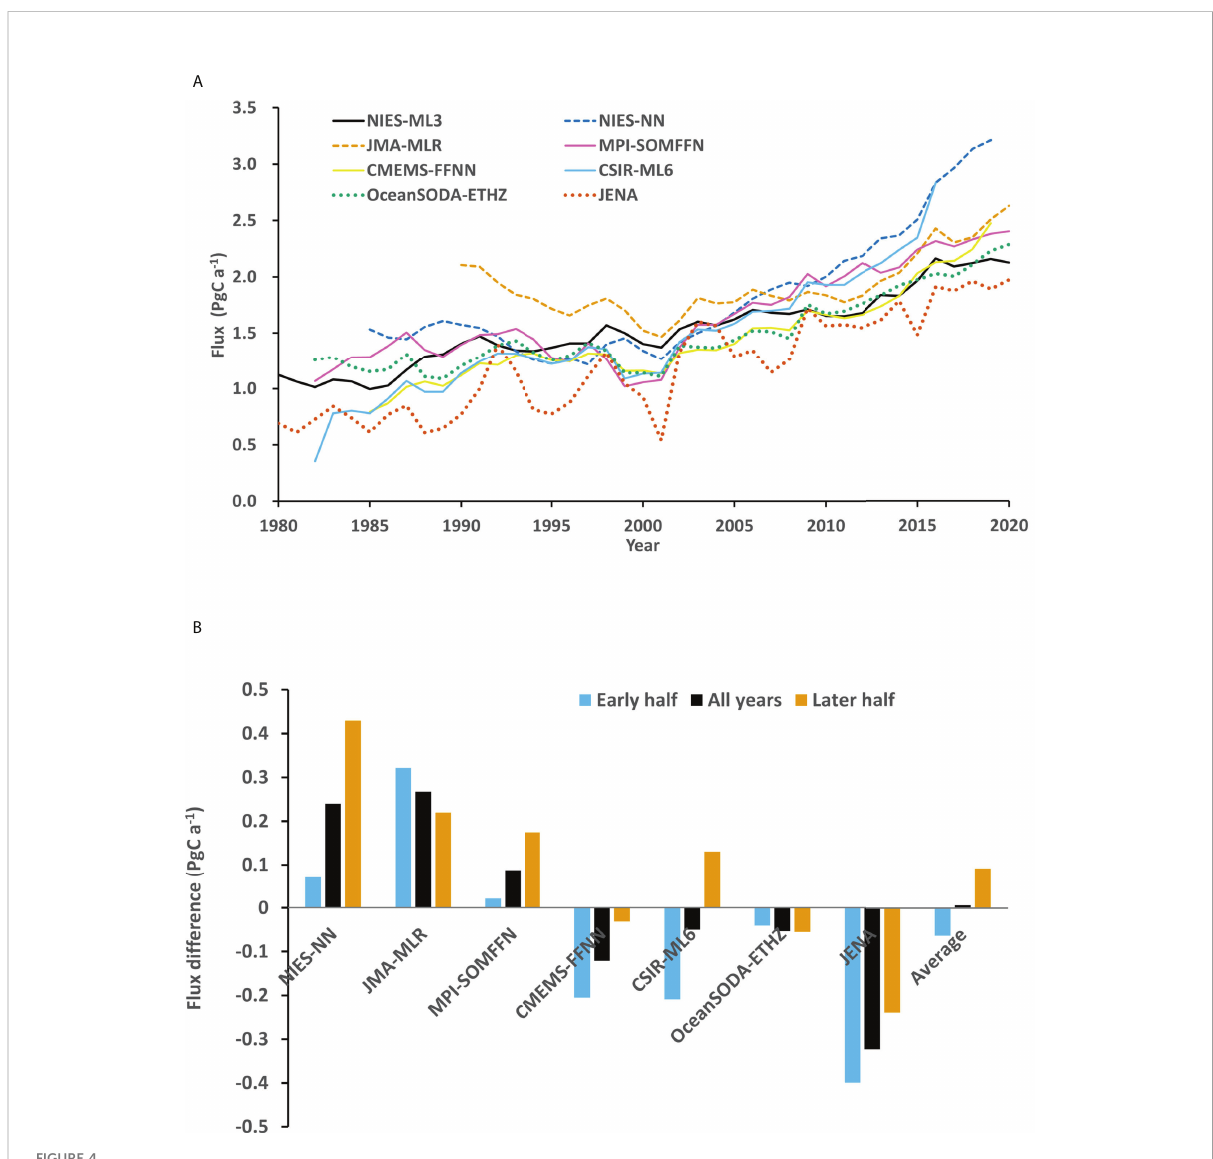
FIGURE 4 Comparisons with machine learning products included in GSB-2021. Fluxes were recalculated by the same method and adjusted to have the same spatial coverage of NIES-ML3. (A) Variations of annual fl uxes with time. (B) Mean differences of third-party products minus NIES-ML3 in the whole available period, the early half years, and later half